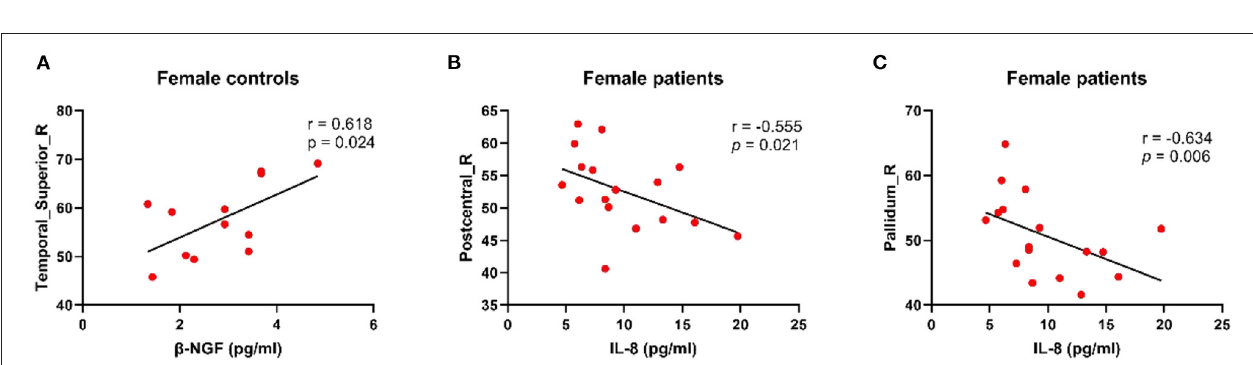
FIGURE 4 | Results of correction between CBF and serum inflammatory factors. (A) Decreased CBF perfusion in the right superior temporal gyrus in female controls was associated with decreased β -NGF, which was positively correlated. (B) In female patients, CBF level in the right posterior central gyrus was negatively correlated with inflammatory factor IL-8. (C) In the right pallidum, the higher the IL-8 concentration is, the lower the blood volume level in that area. CBF, cerebral blood flow; β -NGF, nerve growth factor beta; IL-8, interleukin